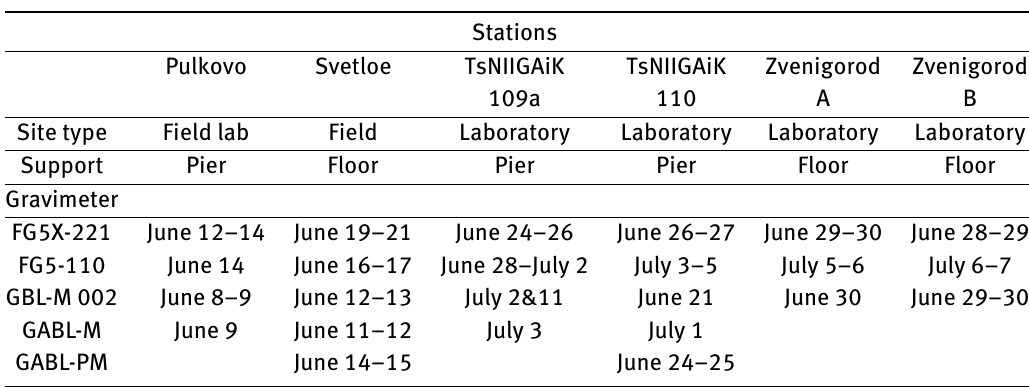
Table 3: Station type and occupation